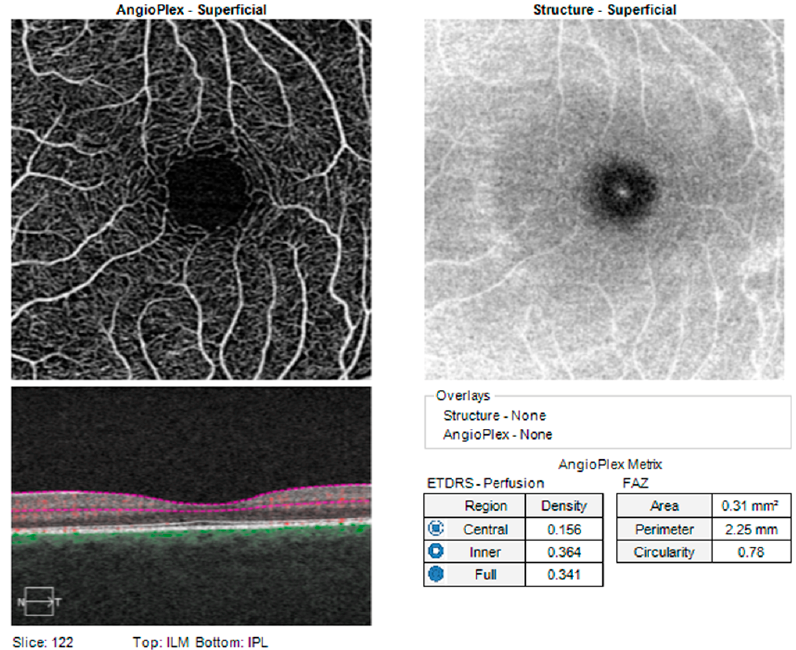
Figure 1. Standard report of a healthy patient obtained with a Cirrus HD-OCT device, Carl Zeiss Inc (ILM—Internal limiting membrane; IPL—Inner plexiform laser; FAZ—Foveal avascular zone; ETDRS—Early treatment diabetic retinopathy study).